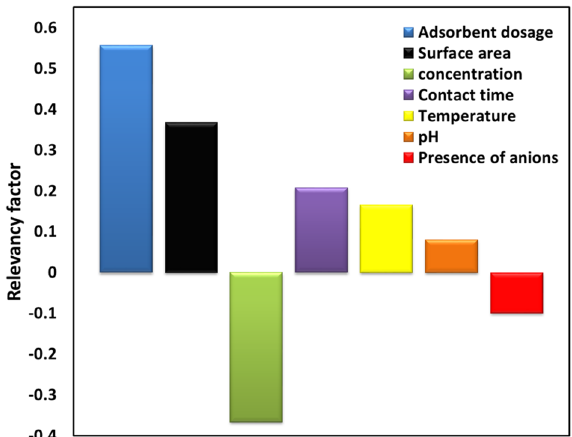
Figure 9. Sensitivity analysis for the developed LightGBM model on different input